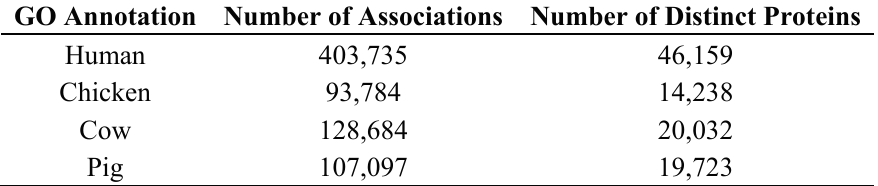
Table 1. Gene Ontology (GO) annotations of main farm animal species.